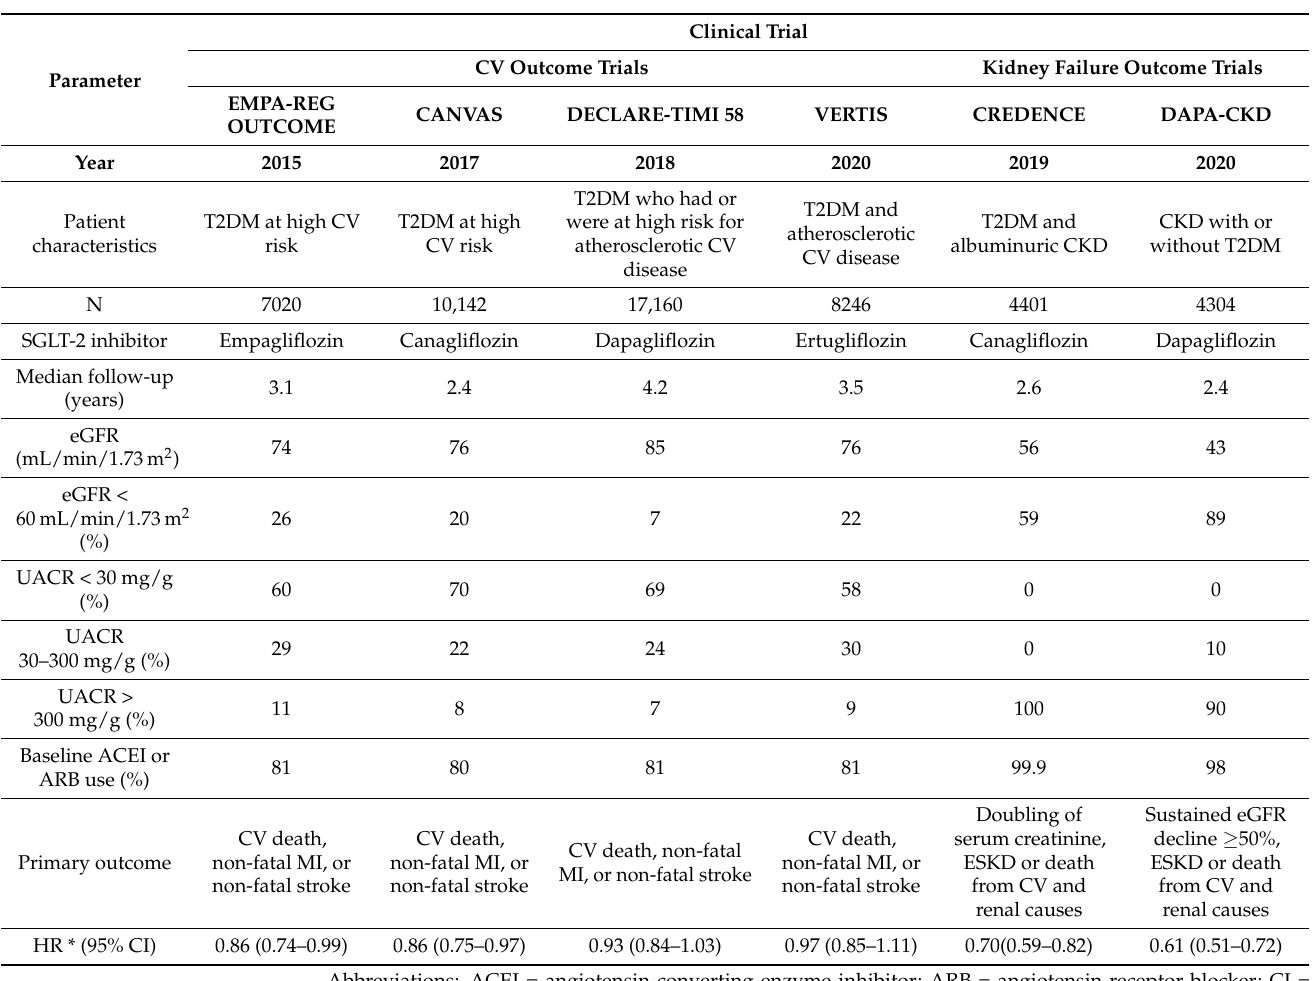
Table 1. Summary of major randomized trials exploring the effect of SGLT-2 inhibitors on cardiovas- cular and kidney failure